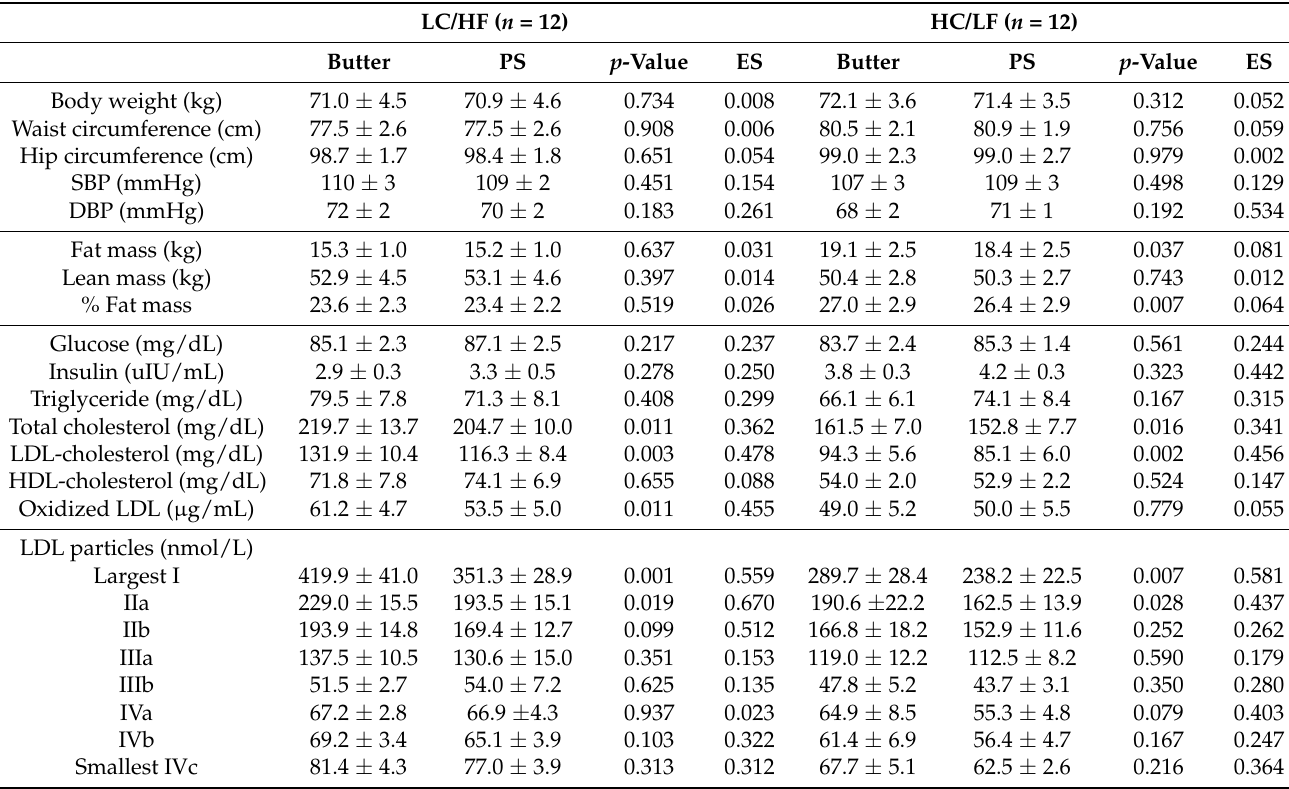
Table 4. Butter versus Palm Stearin (PS) Diet responses in the low-carbohydrate/high-fat (LC/HF) and high- carbohydrate/low-fat (HC/LF) groups.